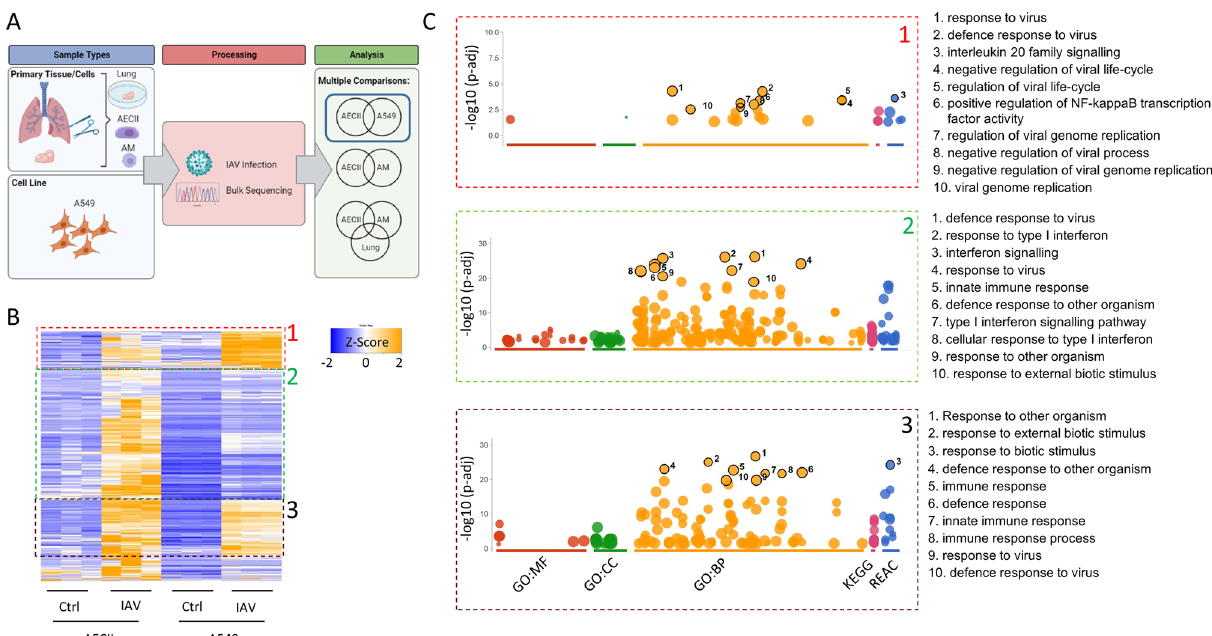
Figure 1. Comparative transcriptional analysis of AECIIs and A549 cells during IAV infection. ( A ) 592 genes are exclusively induced in AECII cells, 503 genes are exclusively induced in A549 cells, and there is a shared set of 468 induced genes. ( B ) The corresponding mRNAs of the shared set differ in abundance and relative induction between the two cell types (1 = similar genes, 2 = more pronounced induction in AECIIs, 3 = more pronounced induction in A549 cells). ( C ) Gene Ontology (GO) categories (BP = biological process, CC = cell compartment, MP = molecular process) and database classifications (KEGG = Kyoto Encyclopedia of Genes and Genomes, REAC = reactome database) highlights different pathway enrichment patterns for these three gene sets. Parts of this Figure were made with